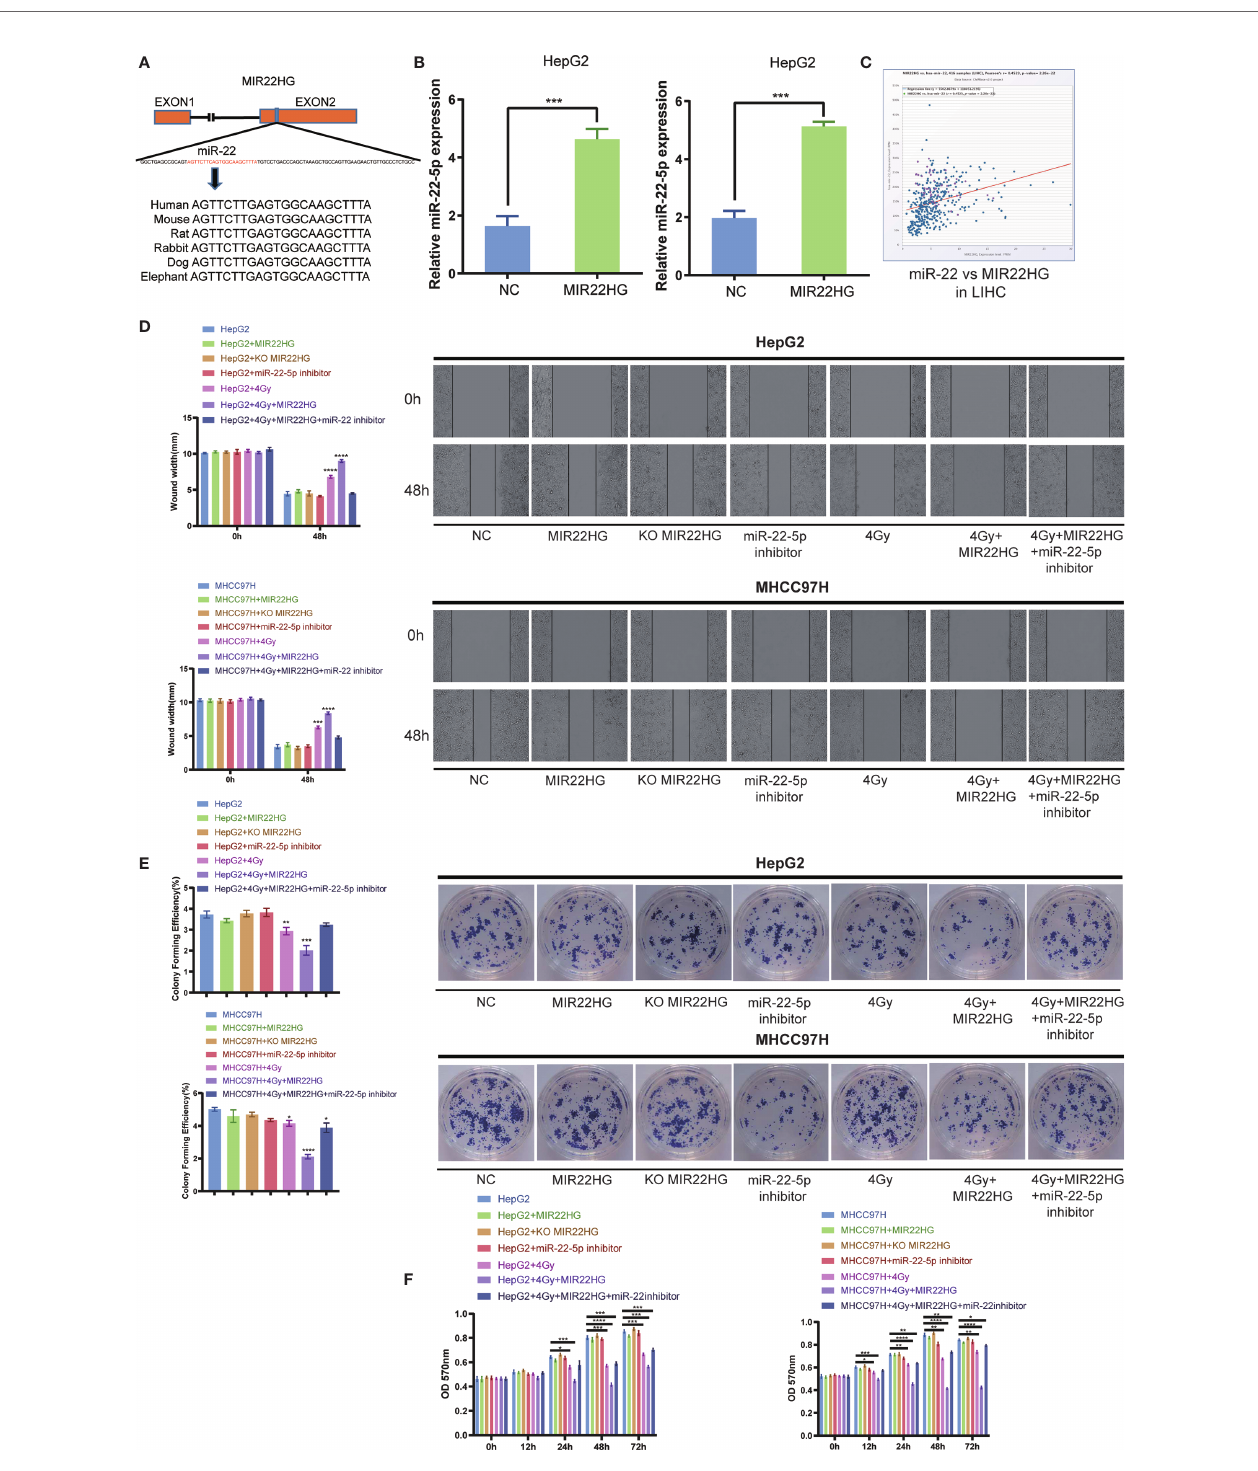
FIGURE 3 | (A) Human miR-22 is located in exon 2 of MIR22HG . miR-22-5p is conserved between humans, mice, rats, rabbits, dogs, and elephants. (B) The miR- 22-5p expression level was detected in MIR22HG-overexpressing HepG2 and MHCC97H cells using qRT-PCR. (C) Correlation of MIR22HG and miR-22-5p expression in TCGA cohorts. (D) Wound healing assay showing the migration of HepG2 and MHCC97H cells with different treatments. *Compared with the HepG2 and MHCC97H groups. (E) Colony formation of HepG2 and MHCC97H cells with different treatments. *Compared with the HepG2 and MHCC97H groups. (F) MTT assay showing the cell proliferation of HepG2 and MHCC97H cells with different treatments. Mean ± SD (n = 3 independent experiments). * p < 0.05, ** p < 0.01, *** p < 0.001, **** p <